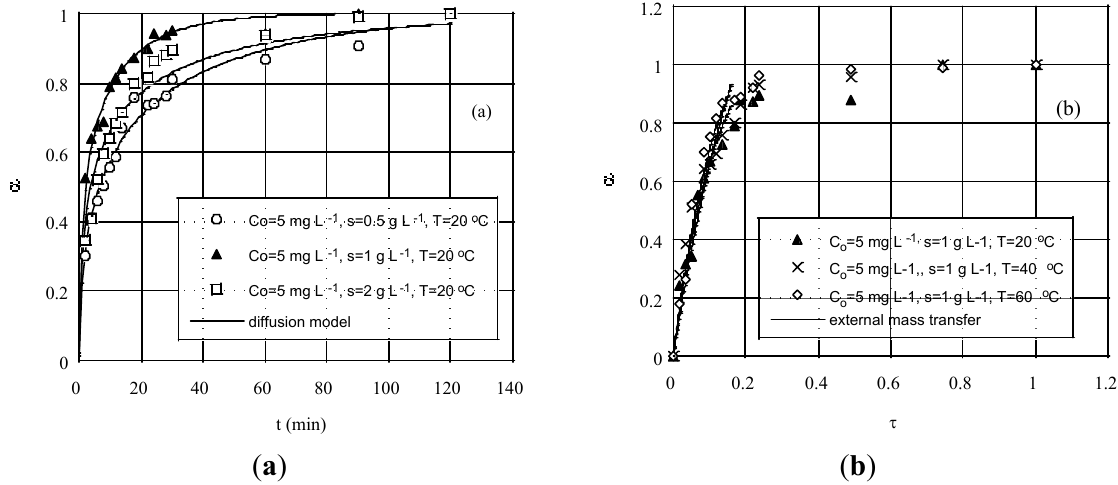
Figure 5. Experimental degree of conversion, α , against predictions based on the solution of the: ( a ) diffusion equation, for various adsorbent loads and ( b ) mass transfer equation, for various temperatures (both at initial chromium concentration of 5 mg·L − 1 ). Reprinted with permission from Ref. [99]; copyright (2004) American Chemical